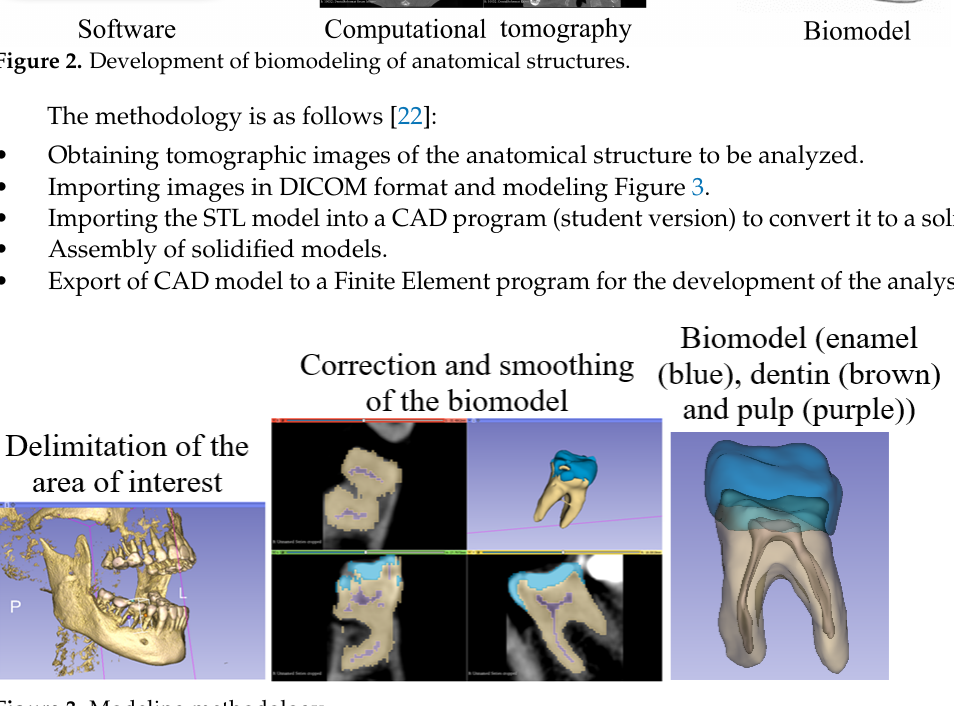
Figure 3. Modeling